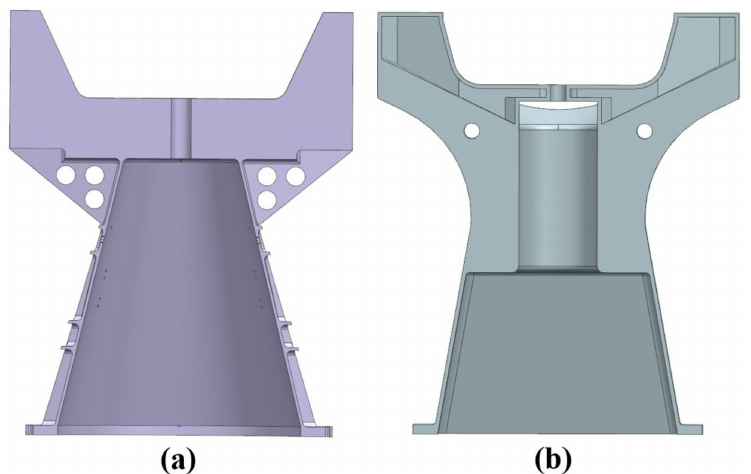
Figure 5. The sectional profile. ( a ) The sectional profile of the original design. ( b ) The sectional profile of the optimized